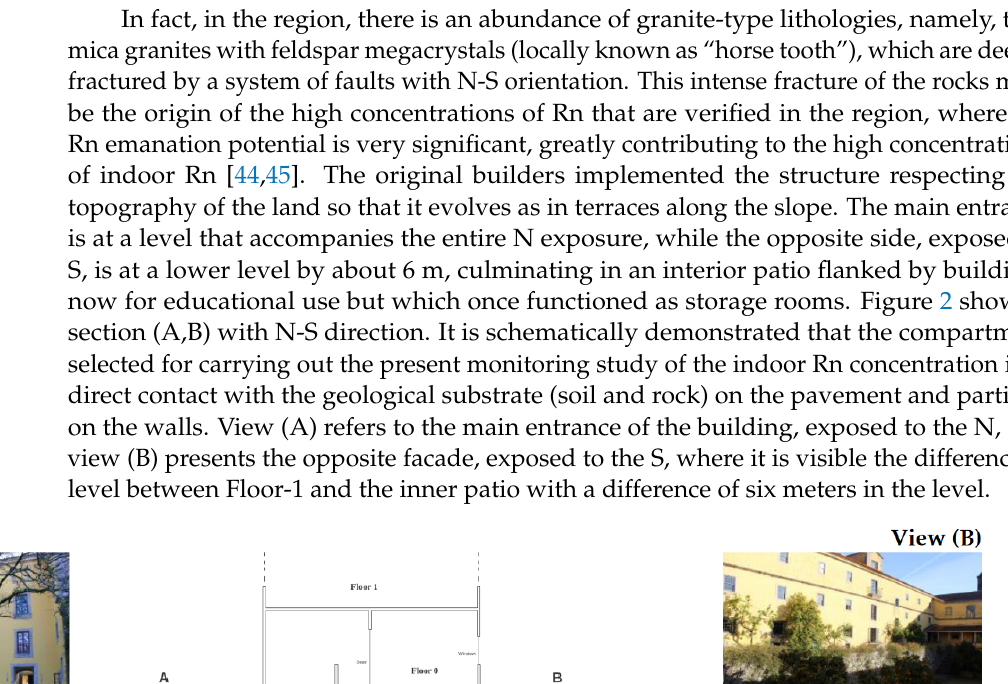
Figure 3. Organization of the works carried out during the monitoring process of the indoor Rn concentration in the compartment selected for the present case study.